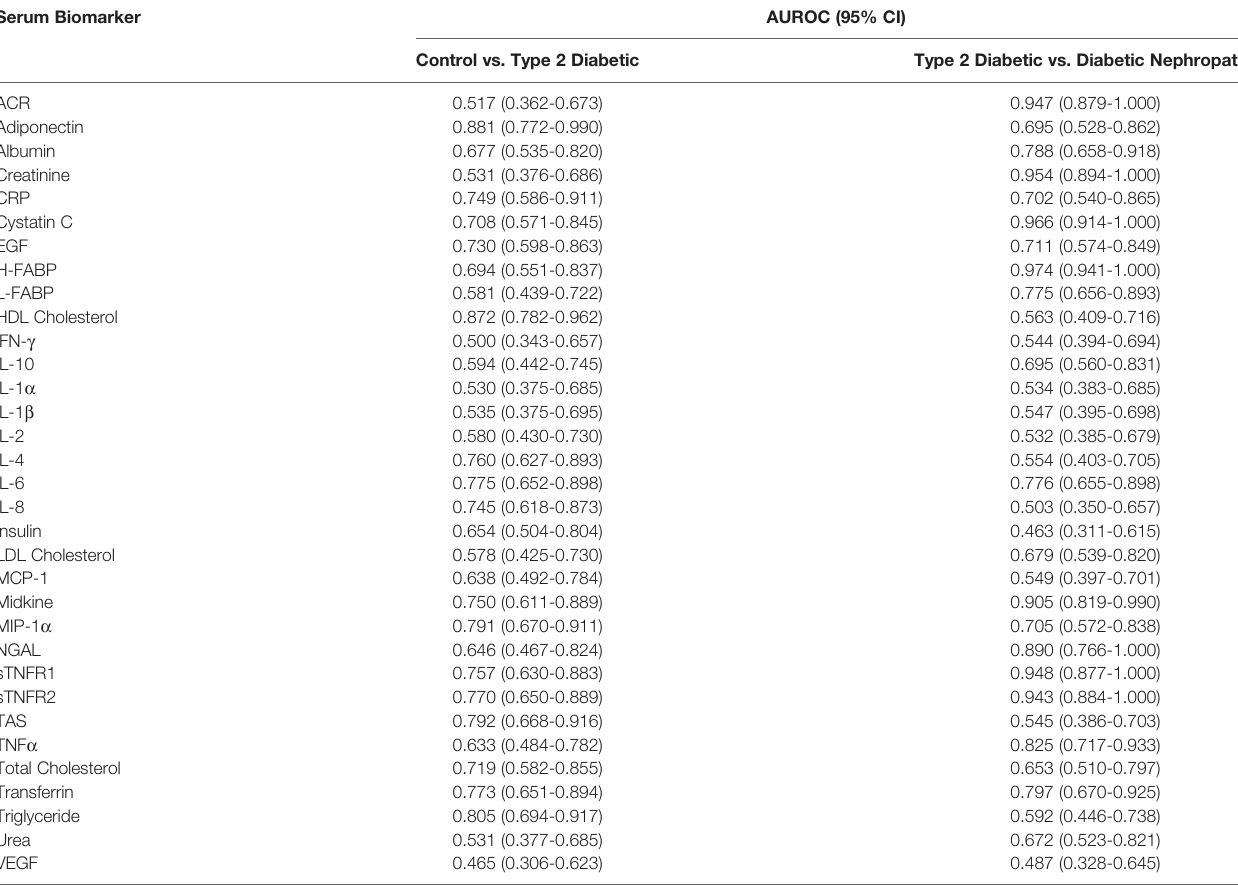
TABLE 4 | AUROC for control vs. T2D and T2D vs. DN. Serum Biomarker